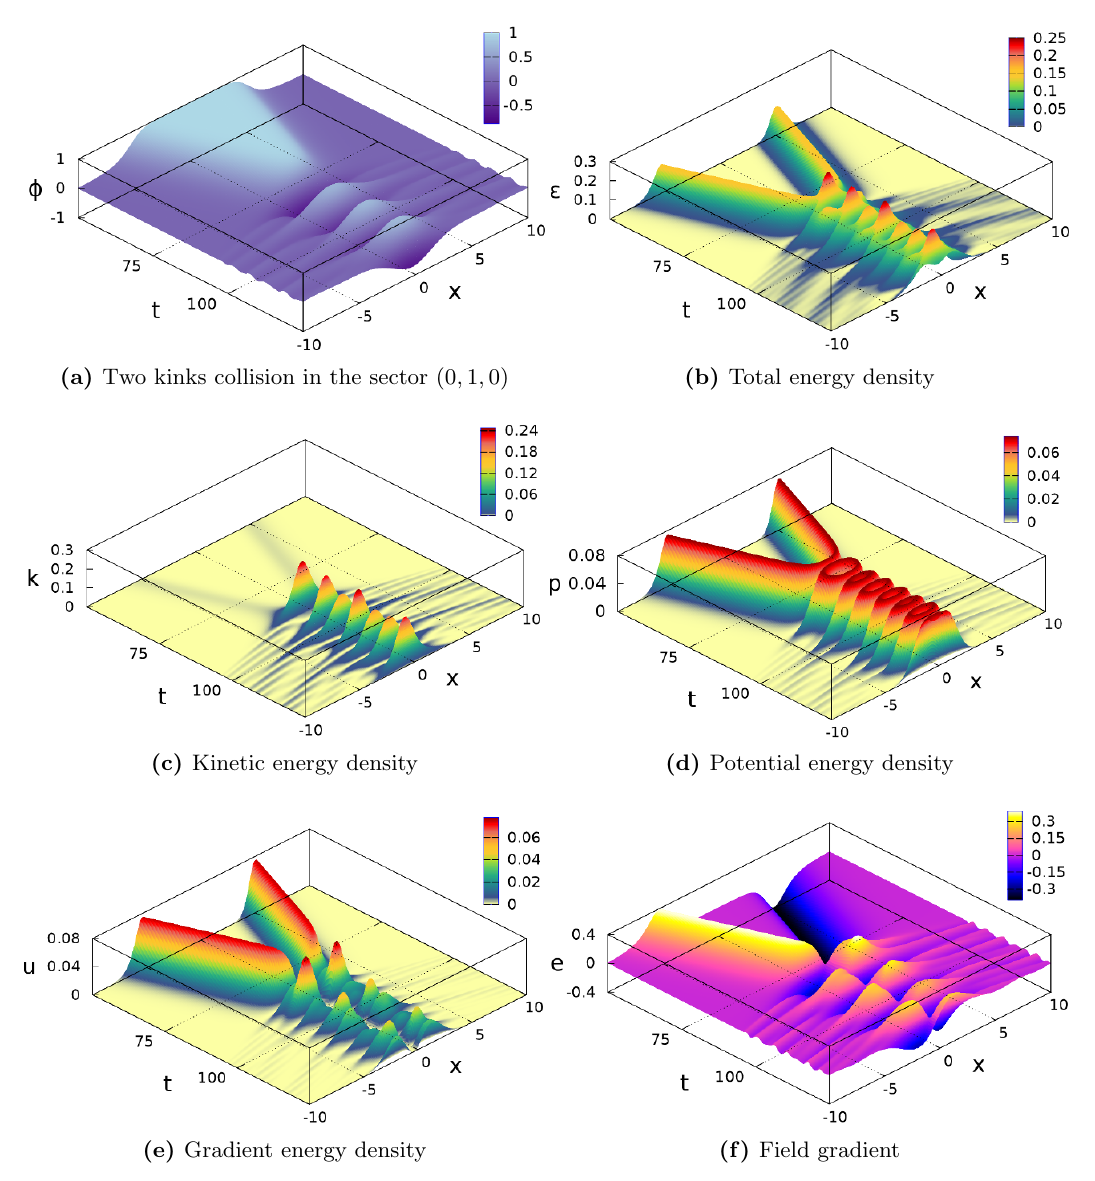
Figure 3. Space-time picture of collision of two kinks in the case of initial con(cid:12)guration (0 ; 1 ;